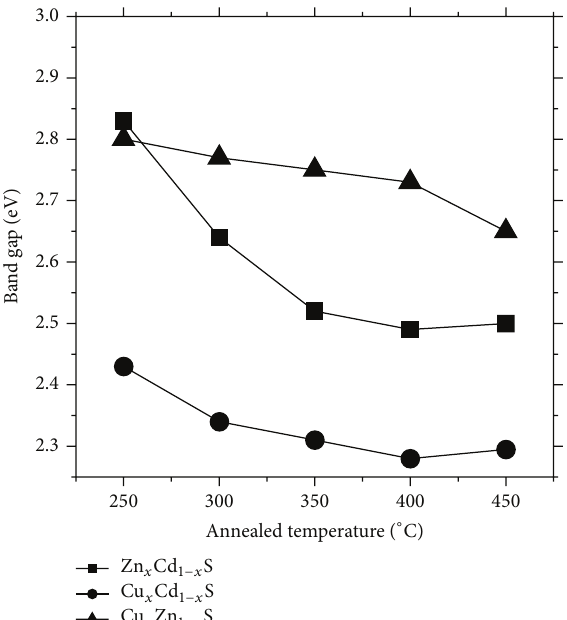
Figure 4: Band gap results as a function of the annealing temperature.